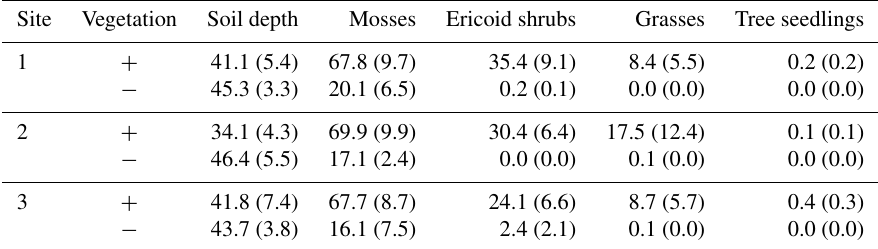
Table 1. Soil depth (cm) and soil surface coverages (%) of mosses, ericoid shrubs, grasses, and tree seedlings on the soil–vegetation interface ( + ) and on bare soil, where vegetation was removed by cutting ( − ) on all experimental plots at three experimental sites (1, 2, and 3) in 2015. The standard error of the mean is given next to the mean.